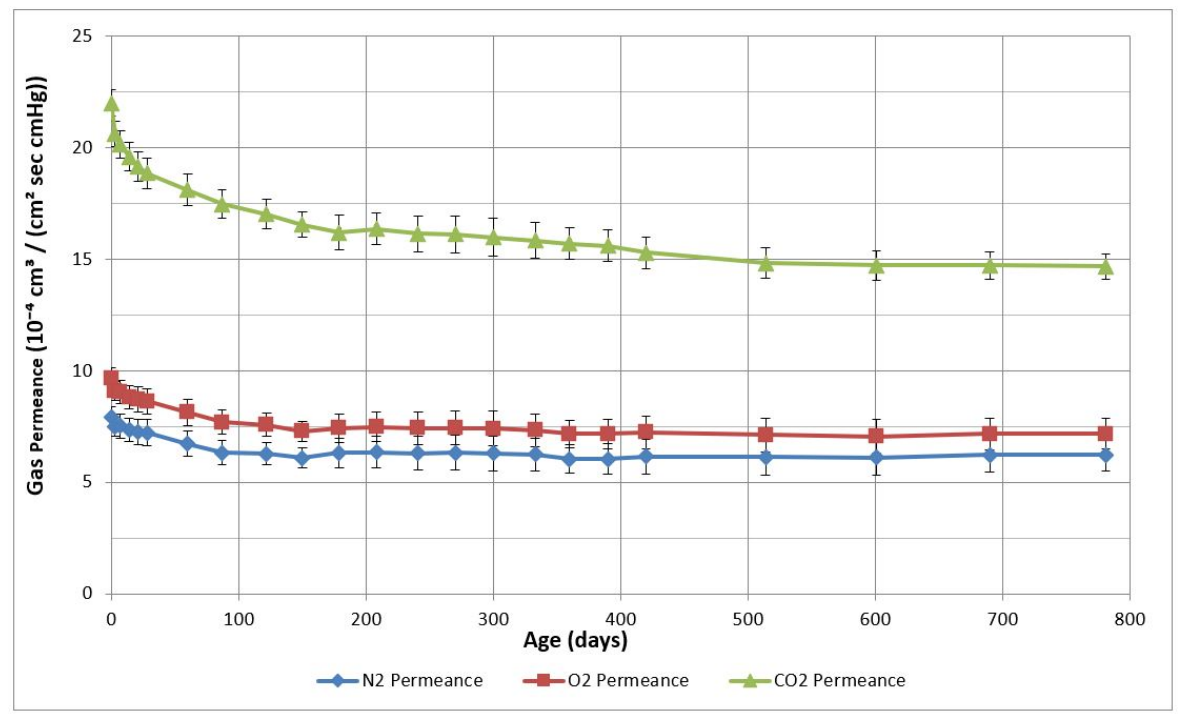
Figure 6. Effect of aging of TMDSO membranes on shepherd hooks in room air on the gas perme-